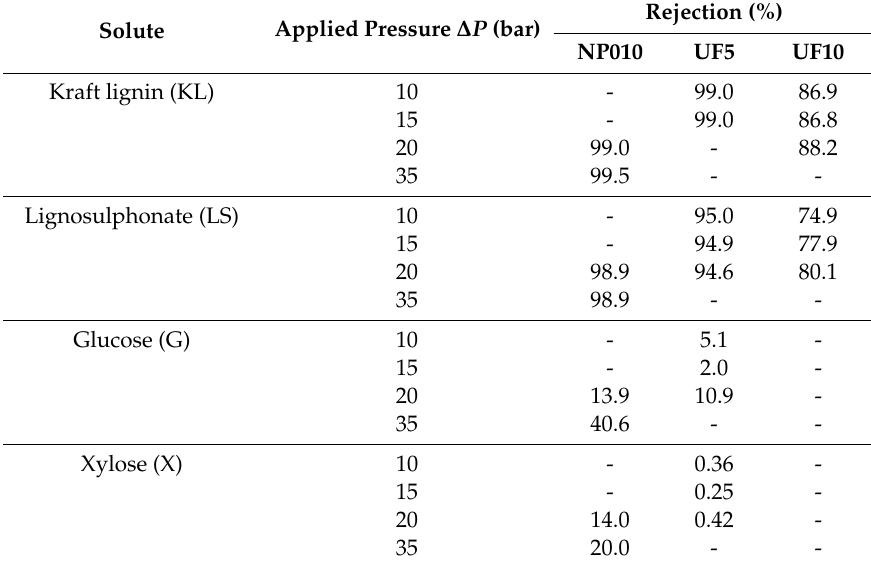
Table 3. Influenceof the operatingpressureon thesoluterejectionofthe NP010, UF5and UF10membranes. Solute Applied Pressure ∆ P